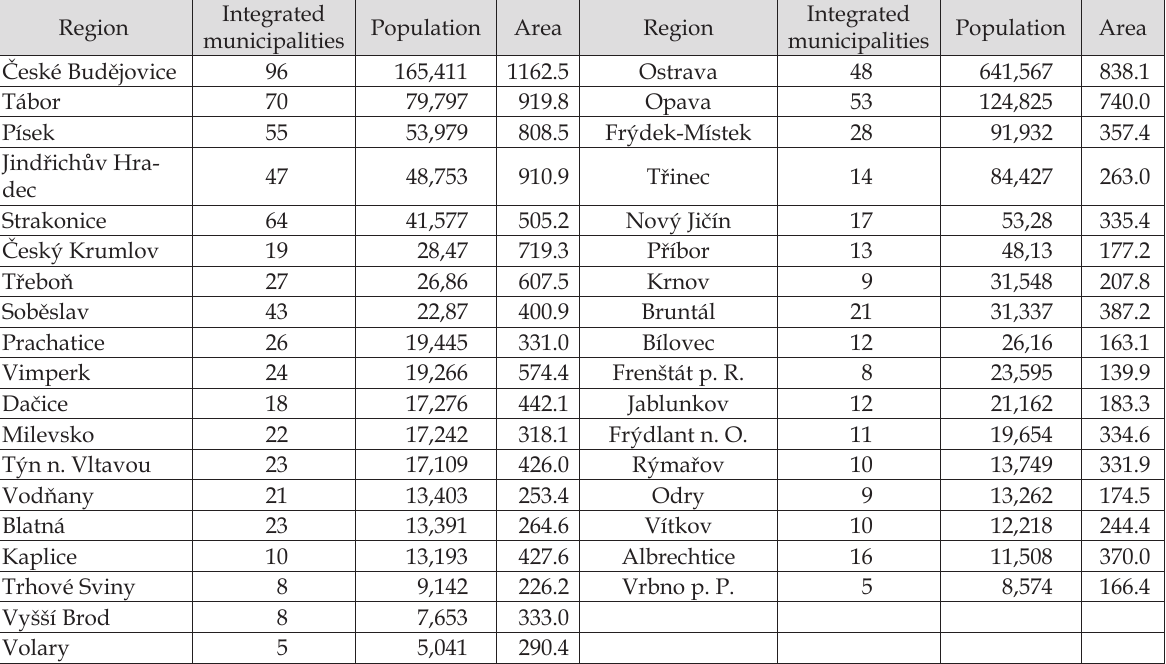
Table 1. Basic size characteristics of the South Bohemian Region and the Moravian-Silesian Region Integrated Region municipalities